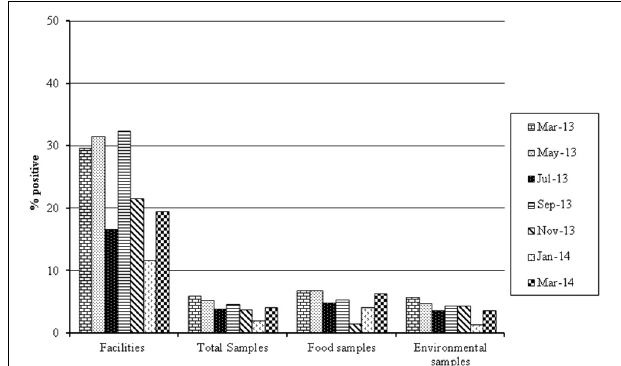
FIGURE 1 | Seasonal variation L. monocytogenes prevalence in samples from different processing facilities isolated between March 2013 and March 2014.